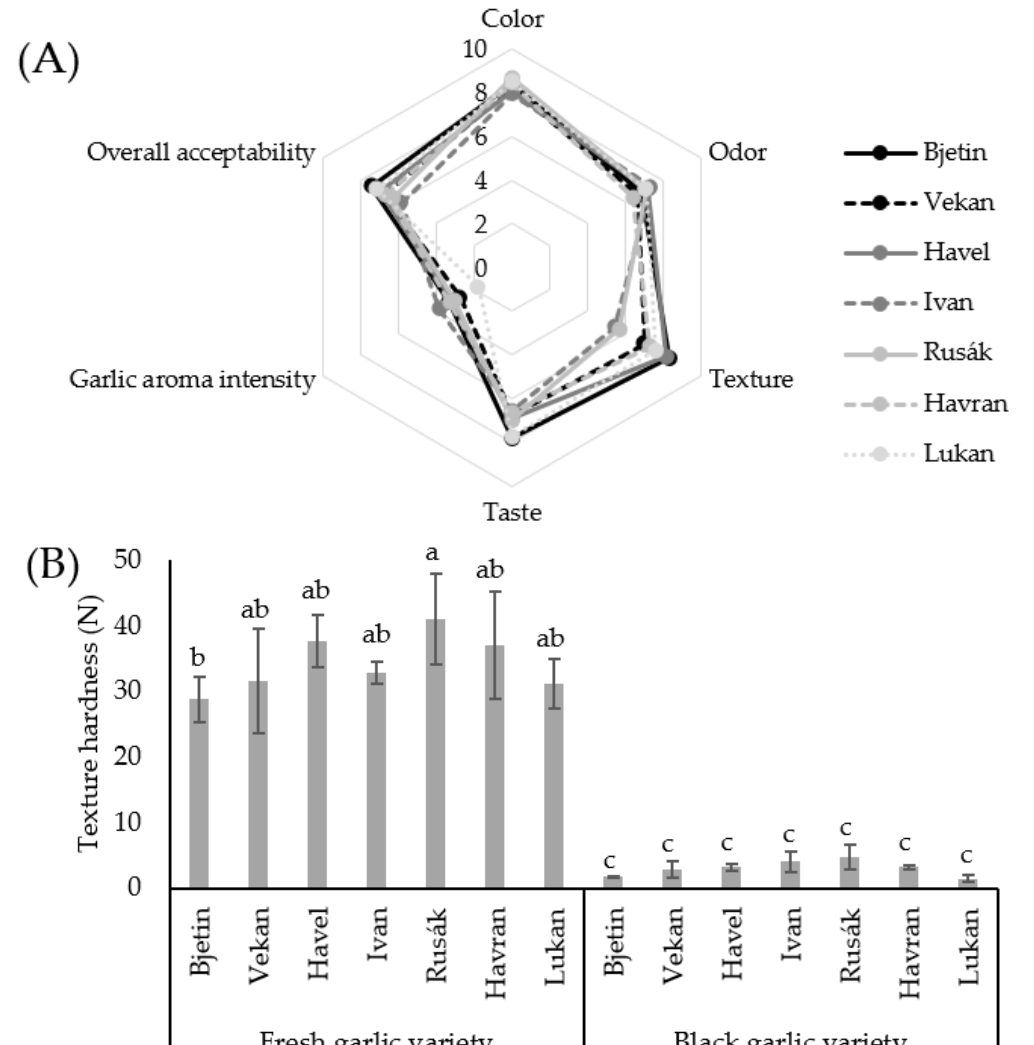
Figure 1. Sensory analysis (0 = dislike extremely, 10 = like extremely) of different black garlic varieties ( A ) and hardness of texture of white and black garlic varieties ( B ). a–c bars, representing means of texture hardness ( n = 4) ± standard deviation, with different letters differ significantly ( p < 0.05).